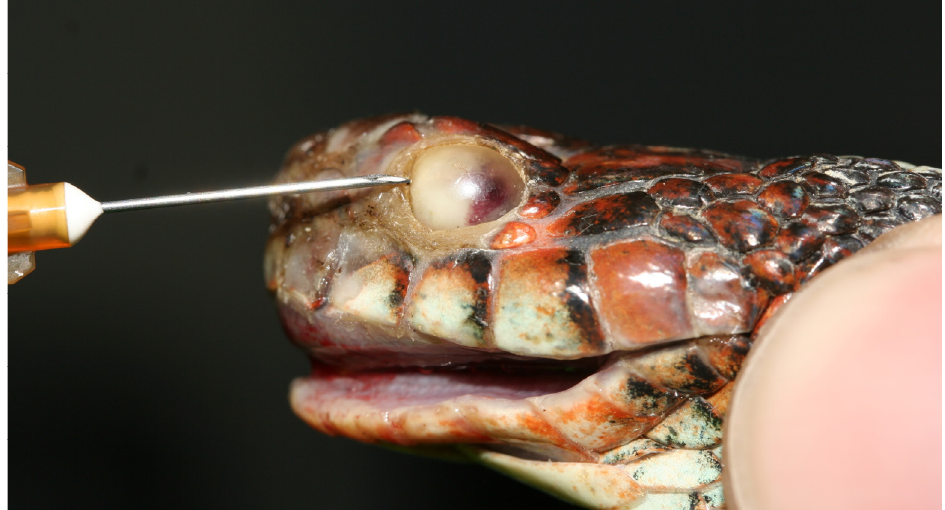
Figure 36. Sampling of a subspectacular abscess in a red-spotted garter snake ( Thamnophis sirtalis concinnus ) via fine needle aspiration through the spectacle.